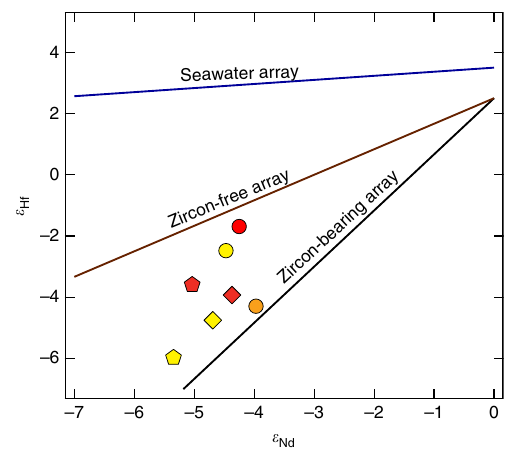
Figure 4 | Hafnium and neodymium dual isotope plot. Arrays of Earth’s oceans, sediments and igneous rocks (compiled by Bayon and others 40 ) are plotted with the hafnium (Hf)-neodymium (Nd) isotope compositions of dust measured in this study. All samples lie within the zircon-free and zircon-bearing array, suggesting that they originate from a combination of near (regional Central Valley) and far (Asian) dust sources. Symbols for the three sites match those in Fig. 1: circles are Shorthair (elevation B 2,700m); pentagons are Providence (elevation B 2,000m); diamonds are Soaproot (elevation B 1,100m); and squares are San Joaquin Experimental Range (elevation B 400m). Colours reflect passage of time during the sampling interval: yellow (July), orange (August), and red